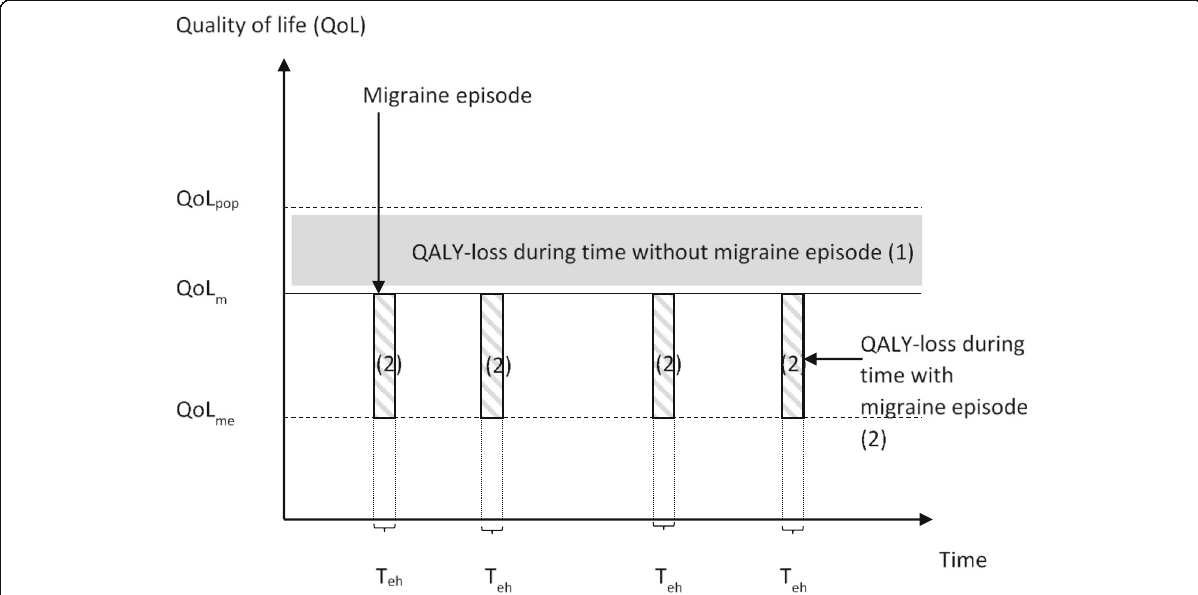
Fig. 1 Simplified illustration of QALY loss related to migraine (QoL pop = QoL for the general population; QoL m = QoL at a day without a migraine episode; QoL me = QoL at a day with a migraine episode; T eh = time with migraine episode in terms of